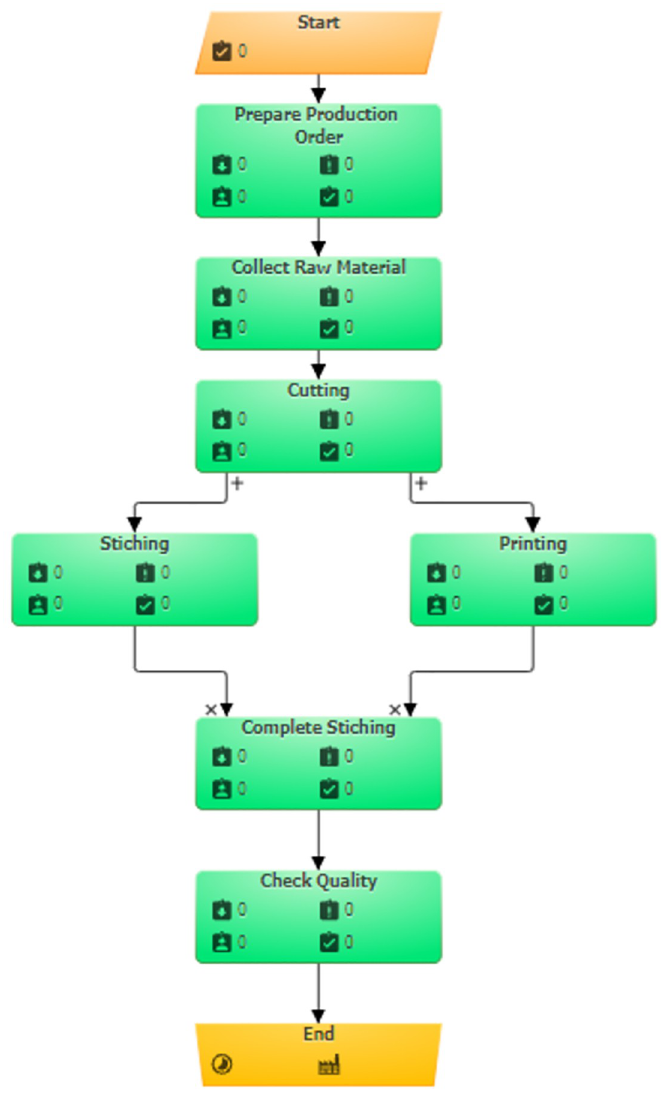
Fig 9. BPSimulator model for shirt manufacturing.